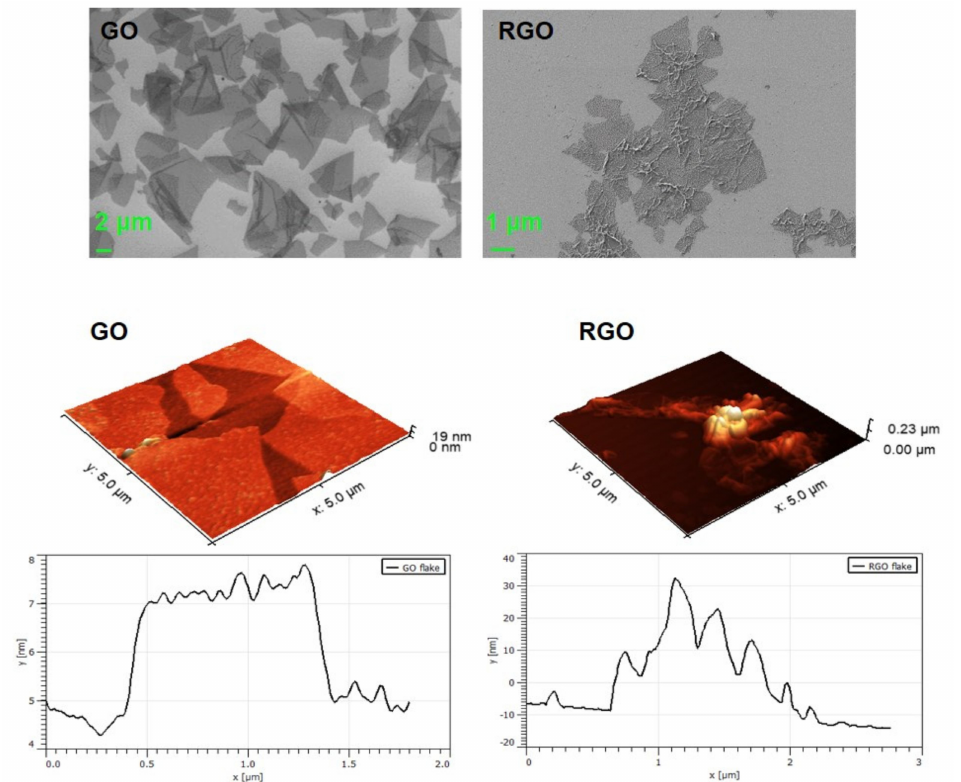
Figure 1. SEM images of graphene oxide (GO) and reduced graphene oxide (RGO) (deposited on Si substrate) and AFM thickness profile of GO and